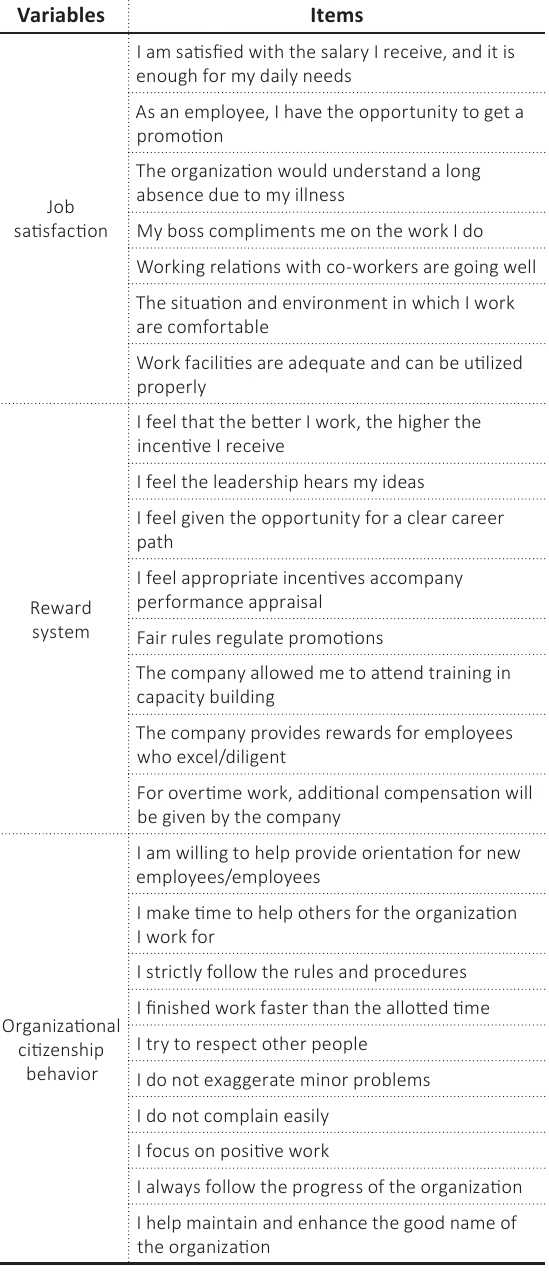
Job Satisfaction Figure 1. Conceptual framework Table 1 . Construct and measurements